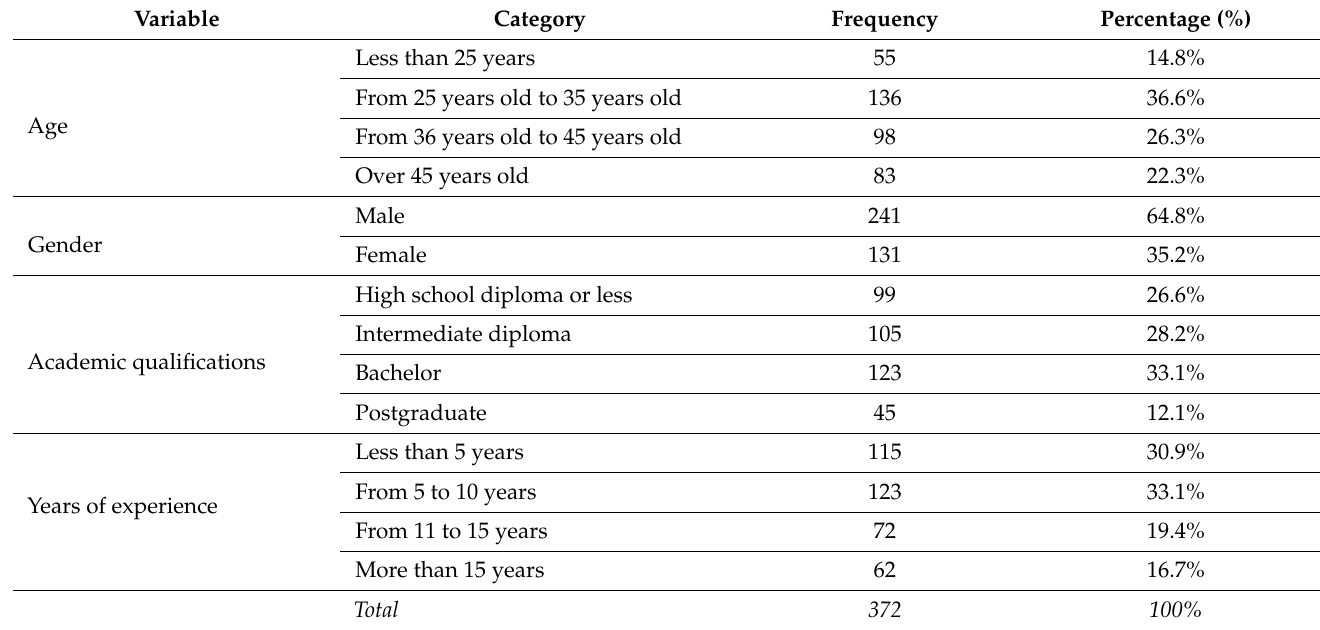
Table 1. Demographic profile of respondents (N =